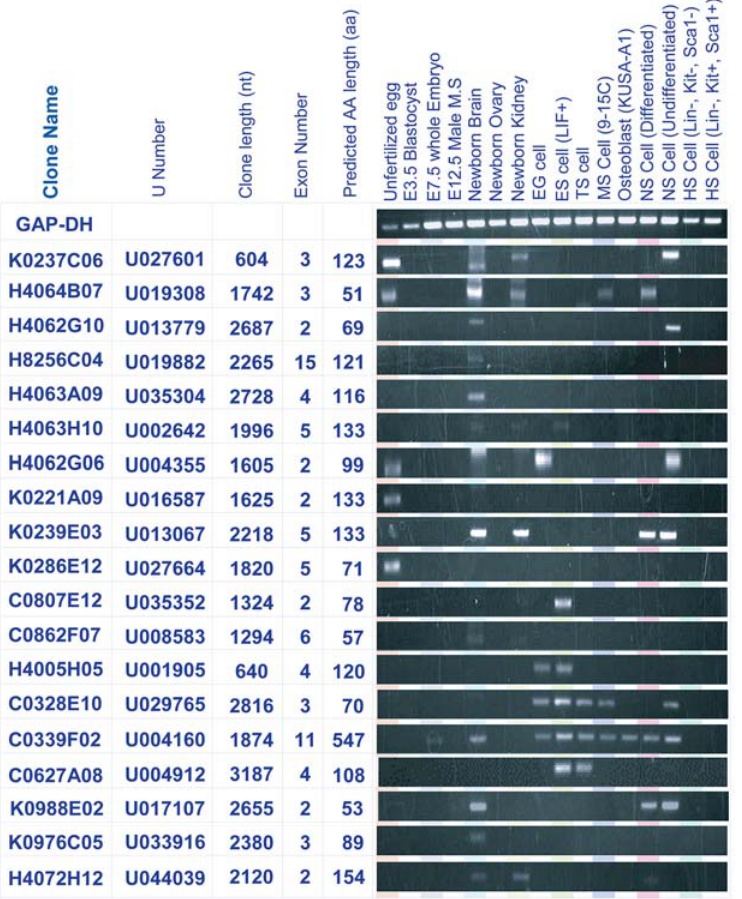
Figure 2. Examples of NIA-Only cDNA Clones and RT–PCR Results Expression pattern of 19 novel cDNA clones in 16 different cell lines or tissues: unfertilized egg, E3.5 blastocyst, E7.5 whole embryo (embryo plus placenta), E12.5 male mesonephros (gonad plus mesonephros), newborn brain, newborn ovary, newborn kidney, embryonic germ (EG) cell, embryonic stem (ES)